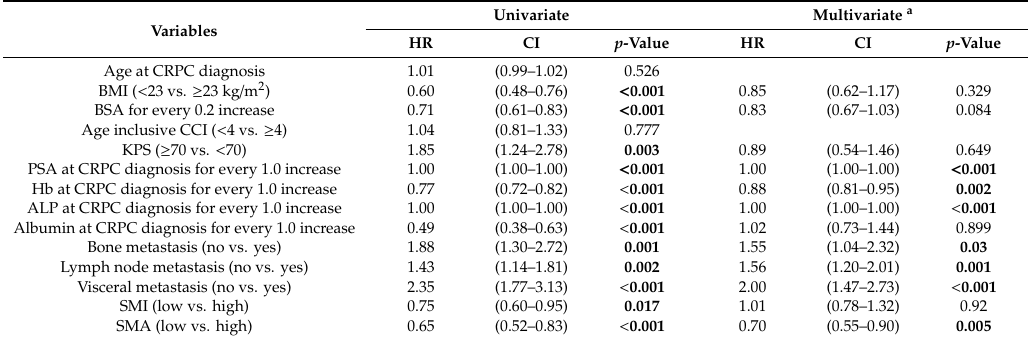
Table 2. Results of Cox regression analysis for patients with castration-resistant prostate cancer. Variables